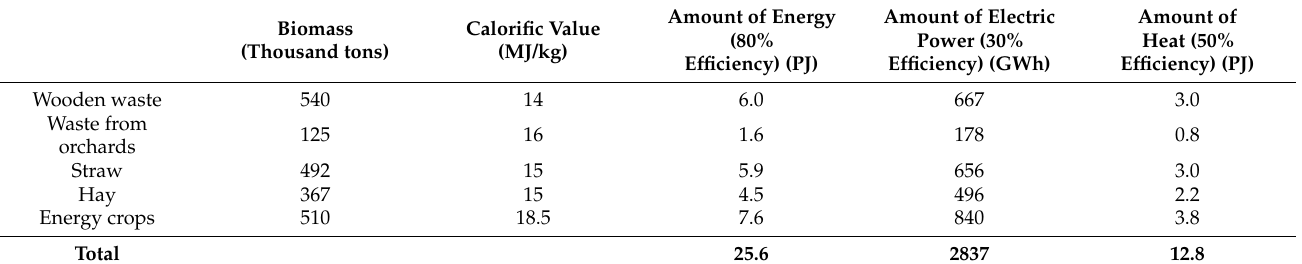
Table 1. Electricity and heat production from solid biomass in the Greater Poland Voivodeship (own calculations).